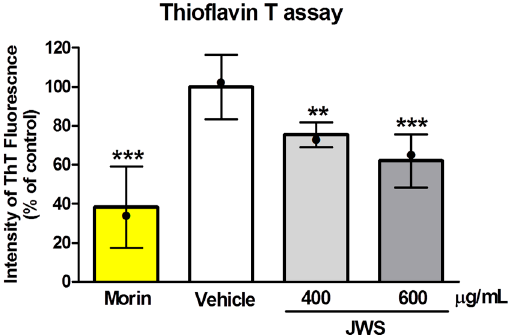
Figure 1. Fluorescence emission intensity of Thioflavin T in the presence or absence of Jowiseungchungtang (JWS). The extent of aggregation of monomeric A β 42 peptides after incubation with morin, vehicle, 400 μ g/mL of jowiseungchungtang (JWS), or 600 μ g/mL of JWS were examined using the ThT assay kit. Data are presented as mean ± SD. Significance by Tukey’s post hoc test following one-way analysis of variance (ANOVA) is indicated as *** p < 0.001 and ** p < 0.01 versus the vehicle-treated group. Median value is indicated as •.